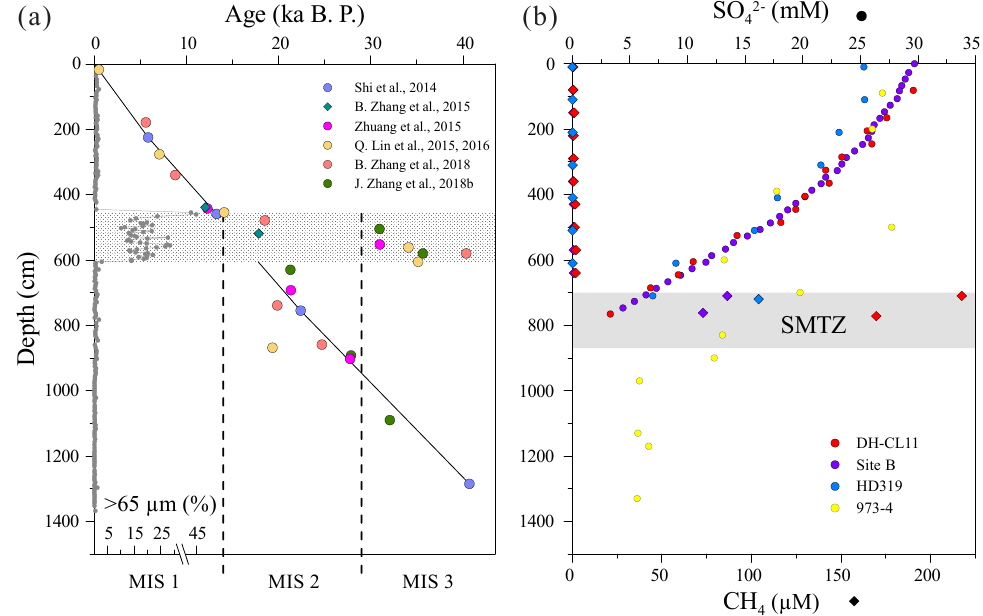
Figure 2. (a) Stratigraphic distribution of the coarse fraction ( > 65µm, R. Lin et al., 2017) and radiocarbon- or δ 18 O-derived age data from Site 973-4. (b) Profiles of interstitial sulfate (circles) and methane (diamonds) concentrations from Site 973-4 (Zhang et al., 2014) and other adjacent sites (Z. Lin et al., 2017; Lu et al., 2012; Ye et al., 2016). Age constraints are AMS 14 C dates derived either from planktonic foraminifera (circles) in calendar years BP (Q. Lin et al., 2015, 2016; Shi et al., 2014; B. Zhang et al., 2018; J. Zhang et al., 2018b; Zhuang et al., 2015) or via correlation with the LR04 benthic oxygen isotope stack (diamonds; B. Zhang et al., 2015). MIS – marine isotope stage. The headspace methane concentrations from Site B and HD 319 were calculated assuming the density of the wet sediments was 1.7gcm − 3 (Tenzer and Gladkikh, 2014). The horizontal bars in (a) and (b) represent either the coarse layer or the SMTZ,